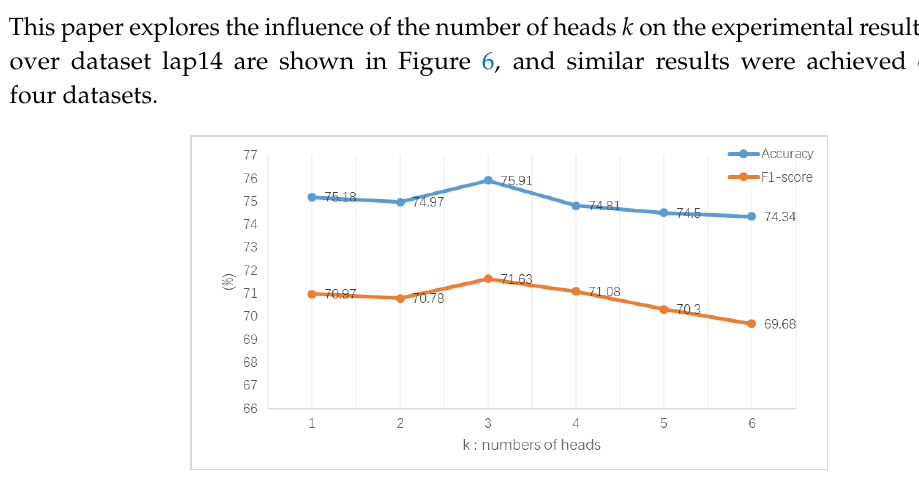
Figure 6. Impact of k over the lap14